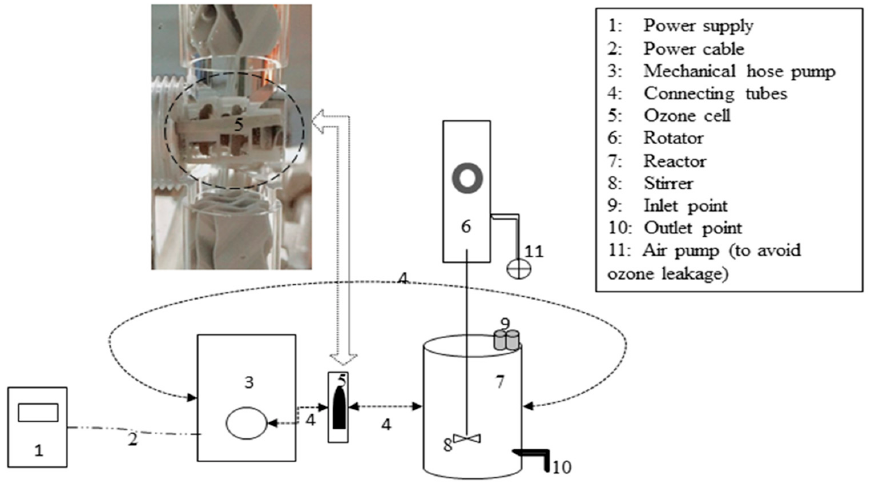
Figure 1. Ozonation reactor system set-up.